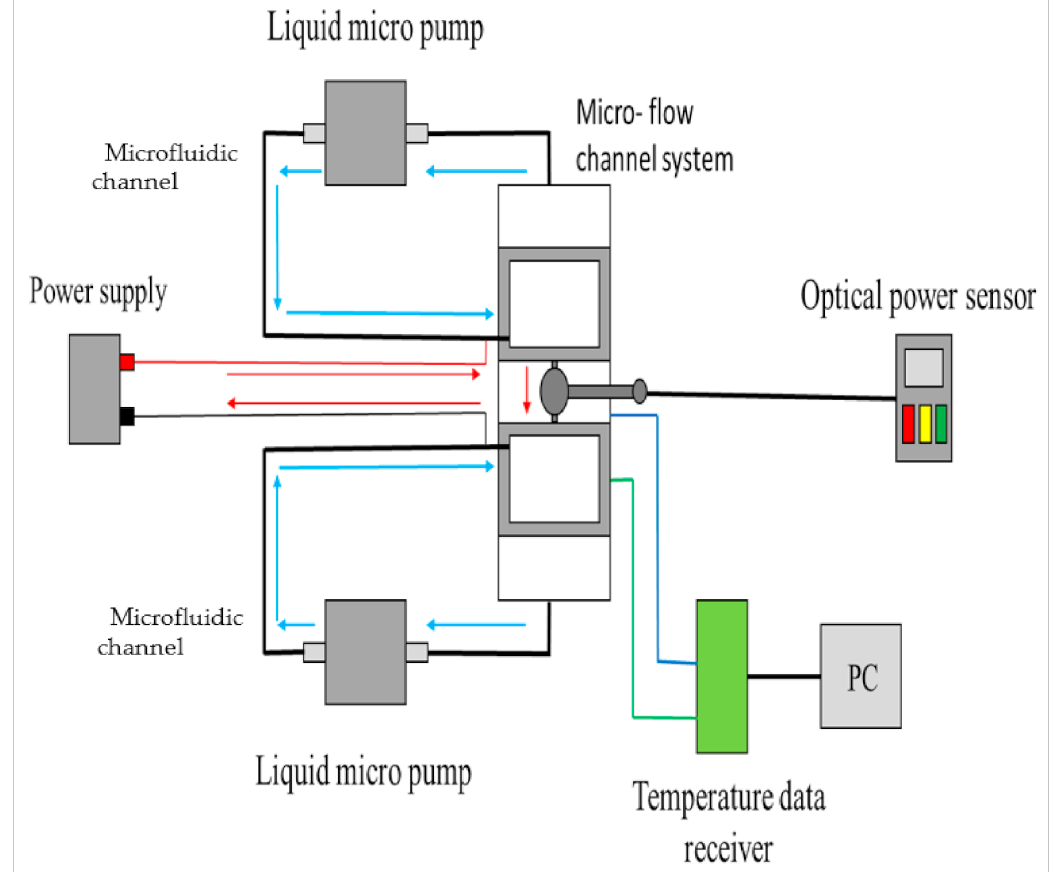
Figure 4. Schematic of the integrated